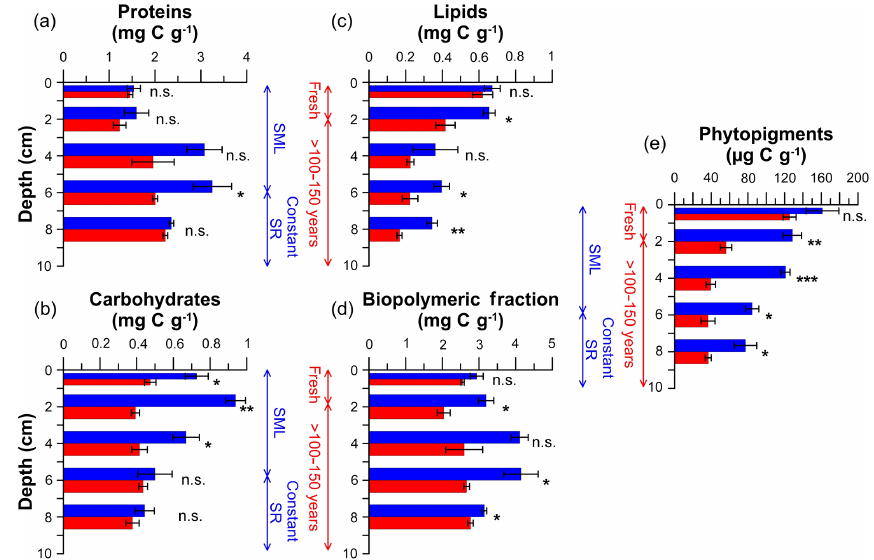
Figure 5. Organic matter quantity of untrawled (blue) and trawled (red) sites. Proteins (a) , carbohydrates (b) , lipids (c) , biopolymeric carbon (d) , and phytopigments (e) . Bar graphs and error bars illustrate the mean values and standard errors at each site and depth of the triplicate sediment cores collected. Asterisks next to bars denote significant difference of post hoc permutational pairwise tests between trawled and untrawled sites: ∗ p < 0 . 05; ∗∗ p < 0 . 01; ∗∗∗ p < 0 . 001; n.s. denotes not significant. Vertical scales indicate the process that has occurred in the depth range given for both untrawled (blue) and trawled (red) sediment cores. SML: surface mixed layer; SR: sedimentation